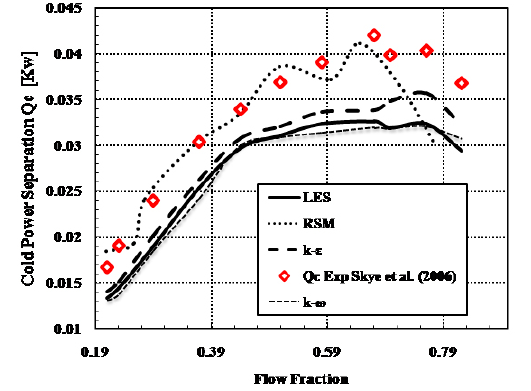
Fig. 16. Variation of the cold power separation for different types of operating turbulence models as a function of cold flow fraction (compared with the experimental results)